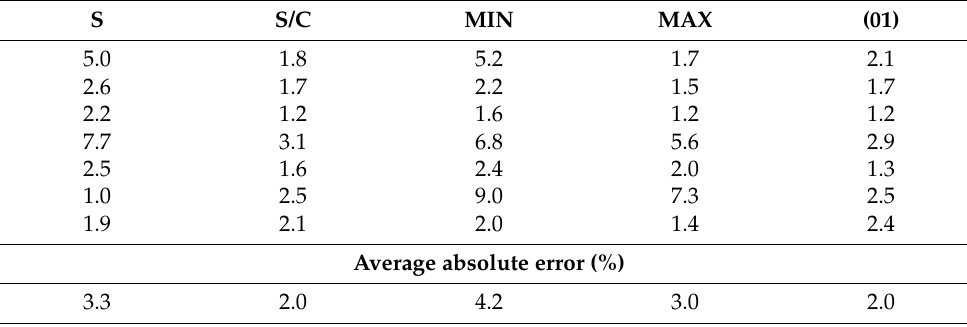
Table 7. Absolute errors of each